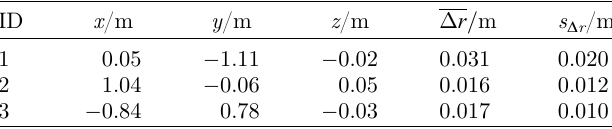
Table 2. Averaged detected coordinates of the three reference sources and spread (mean (cid:2) r and standard deviation s D r ).